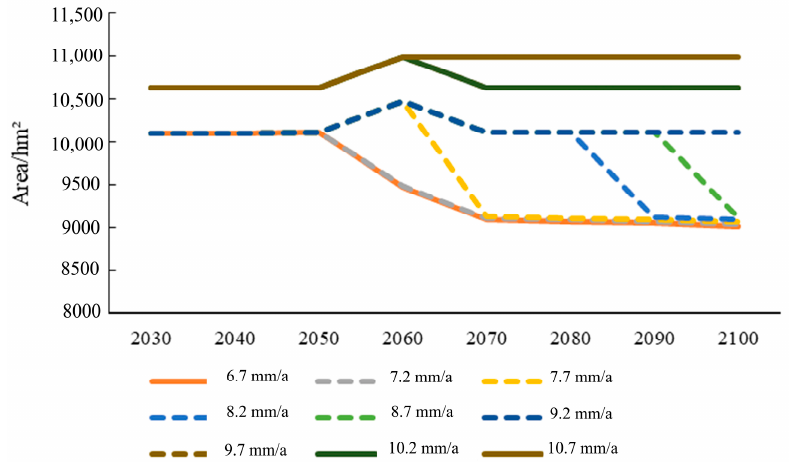
Figure 6. Mangrove changes in Guangxi in SSP5-8.5.